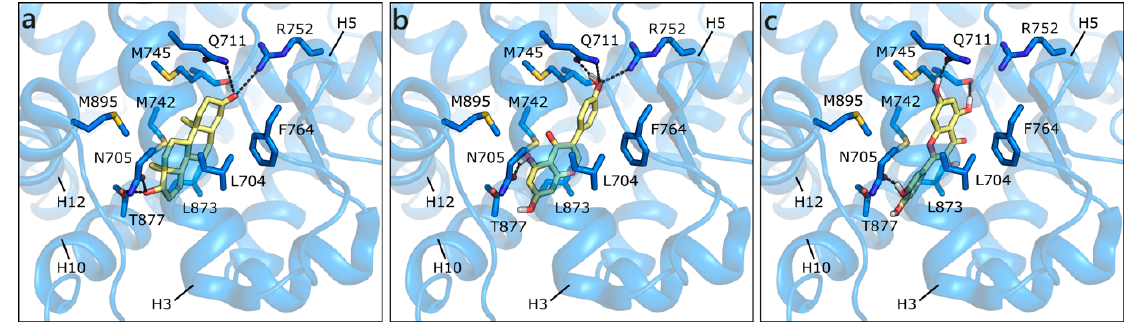
Figure 3. Crystallographic pose of DHT ( a ), and docking poses of GEN ( b ) and QRC ( c ) in wild type AR (PDB ID 3l3x [63]). The protein is shown in transparent blue cartoon, the residues lining the binding site, and the ligands are represented in capped sticks and colored blue and yellow, respectively. Helices and residues lining the pocket are labelled, hydrogen bonds are displayed as black dashed